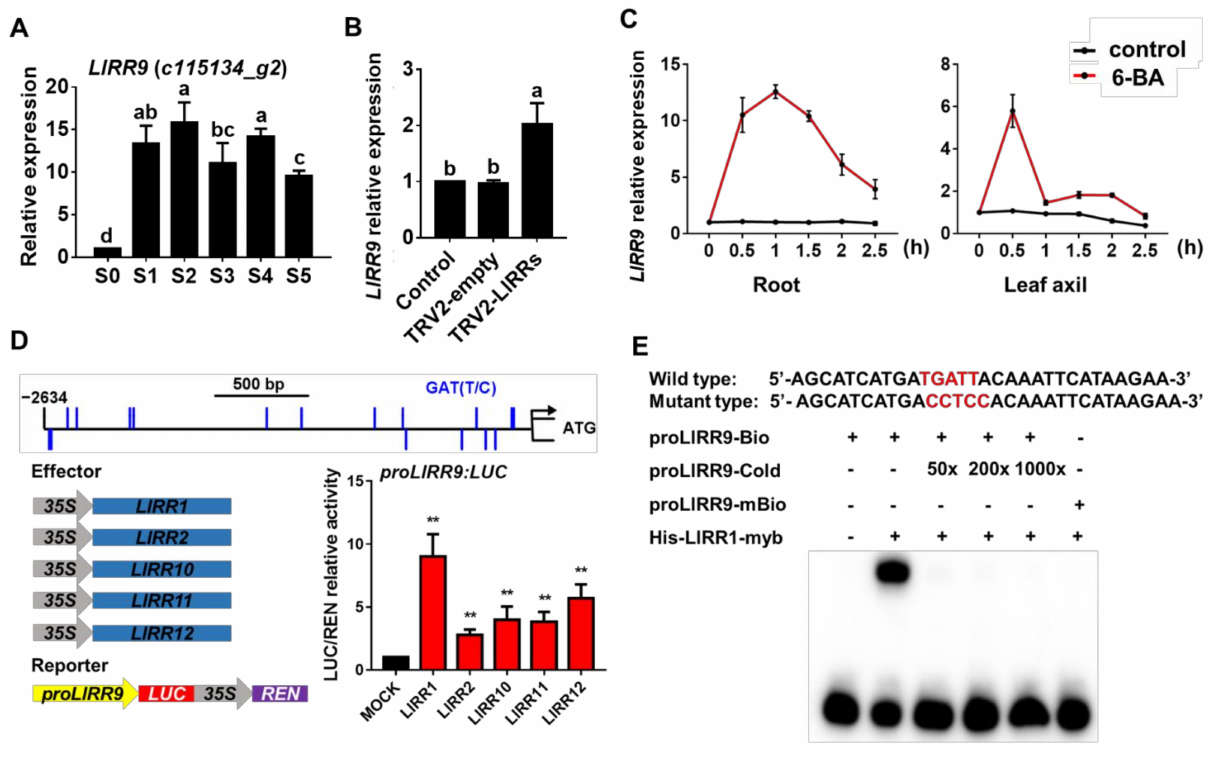
Figure 6. Type–B LlRRs activate the expression of LlRR9 . ( A ) Expression of LlRR9 during bulbil formation. S0–S2: bulbil initiation stage, S3–S4: bulbil primordium formation stage, S5: bulbil structure formation stage. ( B ) Expression of LlRR9 after type-B LlRR silencing. ( C ) The expression of LlRR9 was rapidly induced in both root and leaf axils after 5 mM 6-BA treatment. ( D ) Transient activation assays in Nicotiana benthamiana leaves. The LlRR9 promoter contains a large number of type-B ARR binding elements (GAT(T/C)), and the five type-B LlRRs significantly enhanced proLlRR9:LUC activity in the transient expression system. ( E ) EMSA of LlRR1-His with the LlRR9 promoter region. EMSA confirmed that LlRR1 directly bound to the LlRR9 promoter region (679 to 708 bp upstream of the ATG start codon). Lowercase letters (a–c in A ; a–b in B ) indicate statistically significant differences at p < 0.05. Asterisks in D indicate significant differences compared with the control, with two asterisks indicating p <